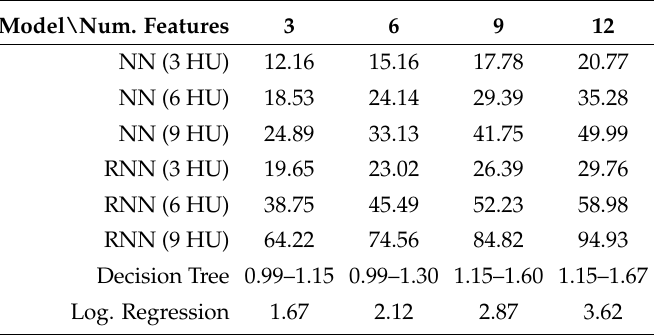
Table 10. Runtime of models in µ s at a 48MHz clock. Model\Num. Features